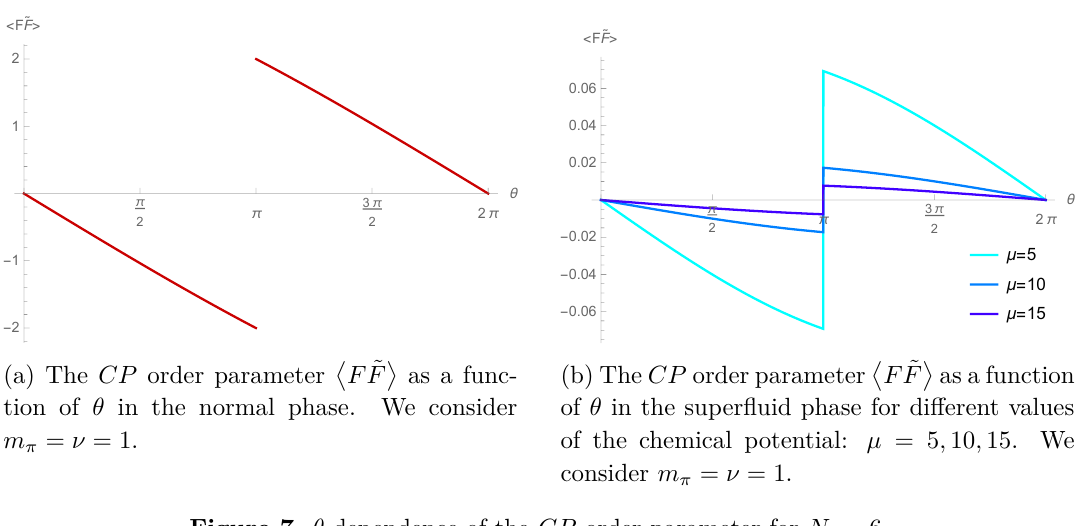
(b) The CP order parameter (cid:10) F ˜ F (cid:11) as a function of θ in the superfluid phase for different values of the chemical potential: µ = 5 , 10 , 15 . We consider m = ν = 1 . π